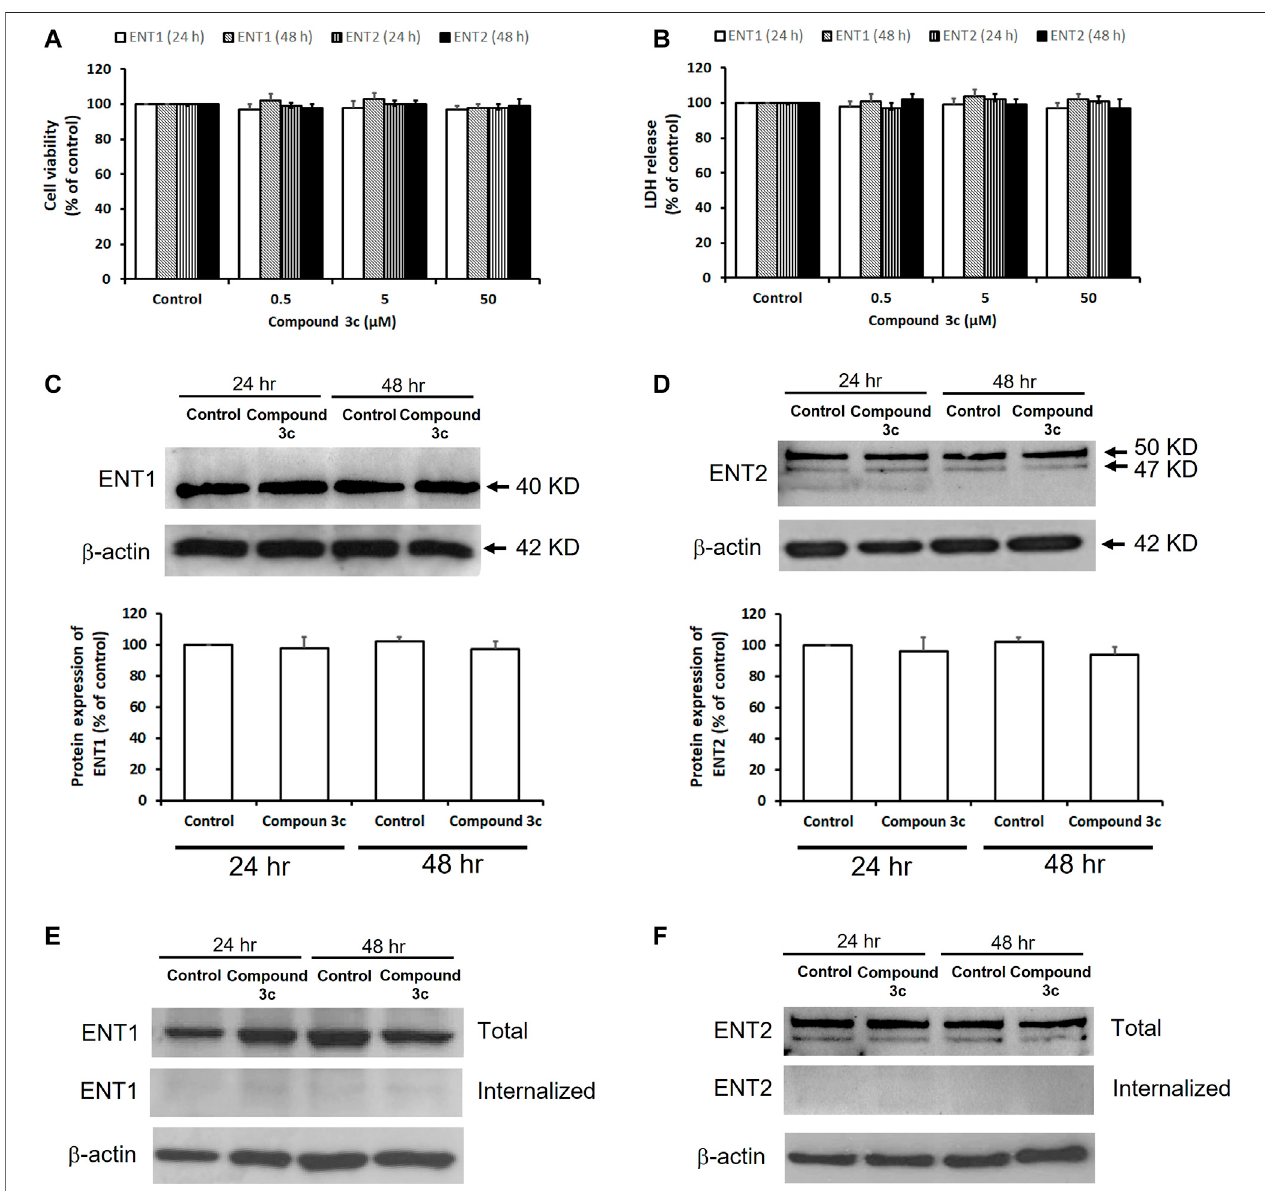
FIGURE 5 | Effects of compound 3c on cytotoxicity and protein expressions of ENT1 and ENT2. Cytotoxicity of compound 3c was measured after 24 h or 48 h treatmentofPK15NTD/ENT1and PK15NTD/ENT2cells withvarious concentrationsofcompound 3c (0.5,5and 50 μ M)or avehicle(0.5% DMSO, asacontrol) (A) The cell viability and (B) cell membrane integrity were determined by the MTT assay and LDH release, respectively (C) PK15NTD/ENT1 and (D) PK15NTD/ENT2 cells were incubated with 50 μ M of compound 3c or a vehicle (0.5% DMSO, as a control) for 24 or 48 h. Western blotting assay was performed to determine the protein expression levels of ENT1 and ENT2, with β -actin as an internal reference. Cell surface proteins of (E) PK15NTD/ENT1 and (F) PK15NTD/ENT2 cells were biotinylated andtreatedwith50 μ Mofcompound 3c oravehicle(0.5%DMSO,asacontrol)for24or48 h.Aftercleavageofextracellularbiotin,internalizedbiotinylatedproteinswere precipitated with immobilized streptavidin beads and detected with an anti-ENT1 and anti-ENT2 antibodies by western blotting. Total ENT1 and ENT2 from whole-cell lysates were also detected for a comparison. β -actin served as an internal reference. Representative blots are from three independent experiments. Data are presented as mean ± SE of three